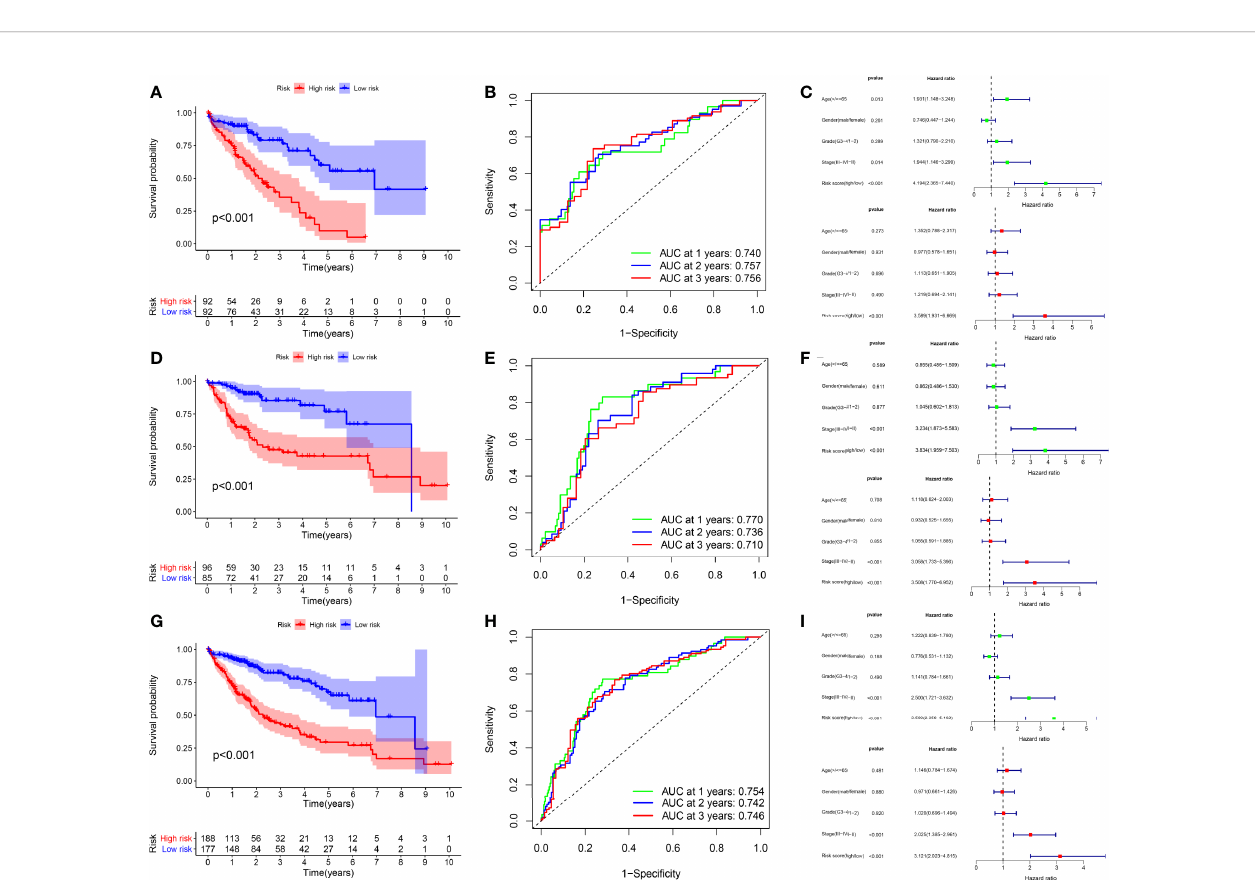
FIGURE 4 | Prognostic assessment of the prognostic model in the TCGA cohort (A – C) The Kaplan – Meier survival analysis, time − dependent ROC analysis, and independence analysis of the signature for predicting the overall survival of patients in the training cohort (n=184) (D – F) The Kaplan – Meier survival analysis, time − dependent ROC analysis, and independence analysis of the signature for predicting the overall survival of patients in the testing cohort(n=181) (G – I) The Kaplan – Meier survival analysis, time − dependent ROC analysis, and independence analysis of the signature for predicting the overall survival of patients in the entire TCGA cohort(n=365). Green represents univariate analysis, and red represents multivariate analysis.